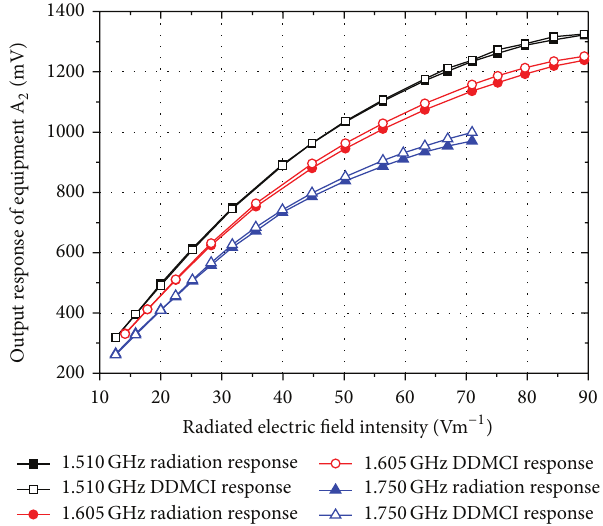
Figure 19: The radiation and DDMCI response curve of